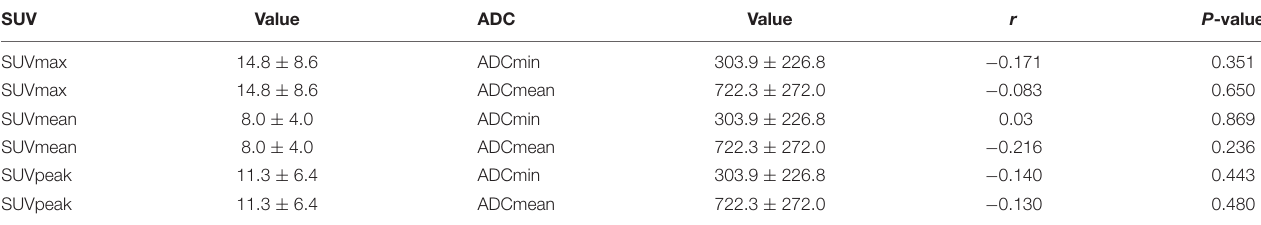
TABLE 5 | The relationship between the ADC and the SUV in PET/MR. SUV Value ADC Value r P -value SUVmax 14.8 ± 8.6